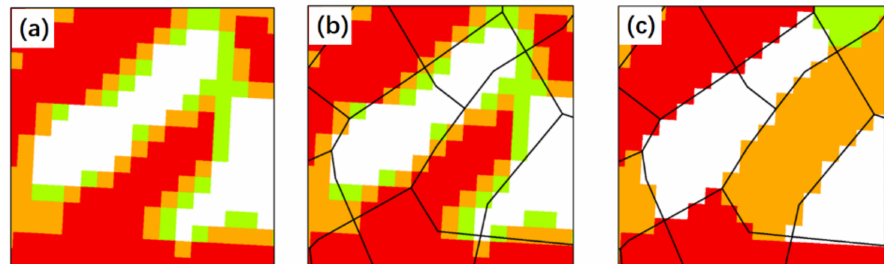
Figure 2. Schematic diagram of calculation method: ( a ) The transient rainfall infiltration and grid- based regional slope-stability model (TRIGRS) calculated safety factor diagram; ( b ) the boundary of the landslide is contrasted by the slope-units; ( c ) the results of the treatment using the slope-units.